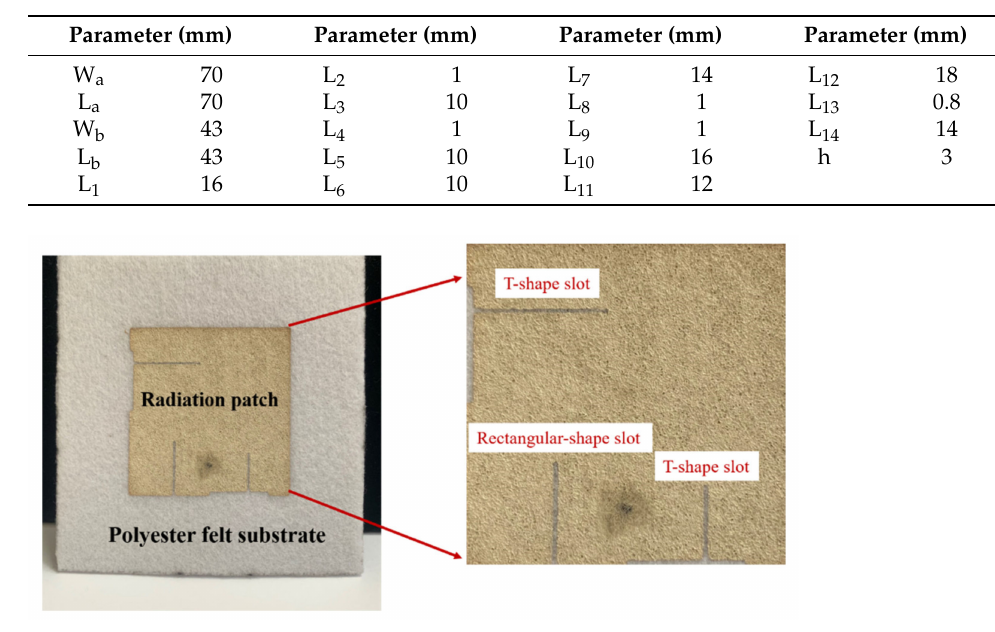
Figure 4. Prototype of the slotted microstrip